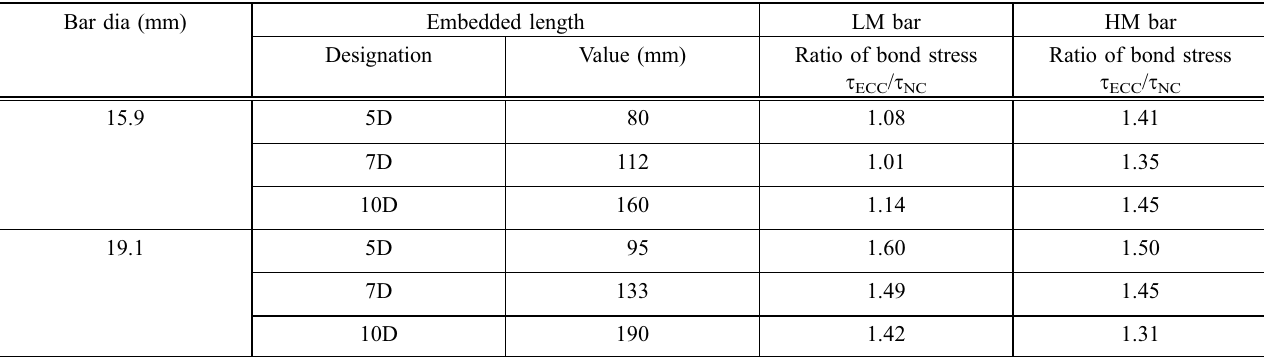
Table 5 Comparison of bond stress between ECC and NC specimens. Bar dia